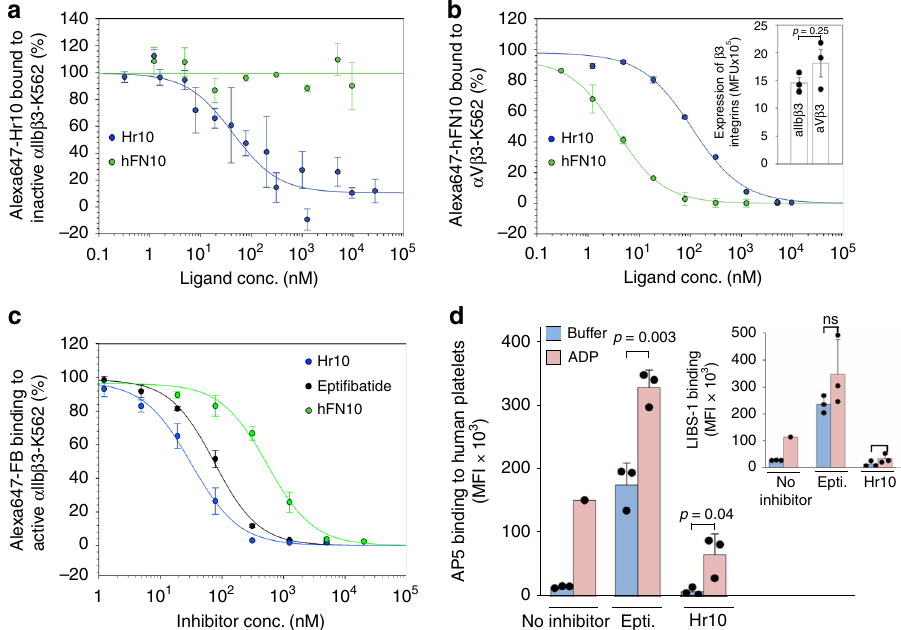
Fig. 2 Binding properties of Hr10. a Dose – response curves comparing displacement of Alexa647-labeled Hr10 from inactive α IIb β 3-K562 cells by unlabeled Hr10 ( n = 5, 9 replicates) or hFN10 ( n = 3) analyzed by fl uorescence-activated cell sorting (FACS). The mean fl uorescence intensity (MFI) values for individual experiments were initially fi t with a binding curve to determine minimum and maximum MFI values to use in scaling the data. The blue and green lines in a – c are a least-squares fi t to the averages. The points and error bars indicate the mean and standard error for the scaled data. b Dose – response curves comparing displacement of Alexa647-labeled hFN10 binding to α V β 3-K562 cells by unlabeled hFN10 or Hr10. Data were generated as in a . Inset, histograms (mean + / − s.d., n = 3 independent experiments) showing stable expression of the respective recombinant β 3